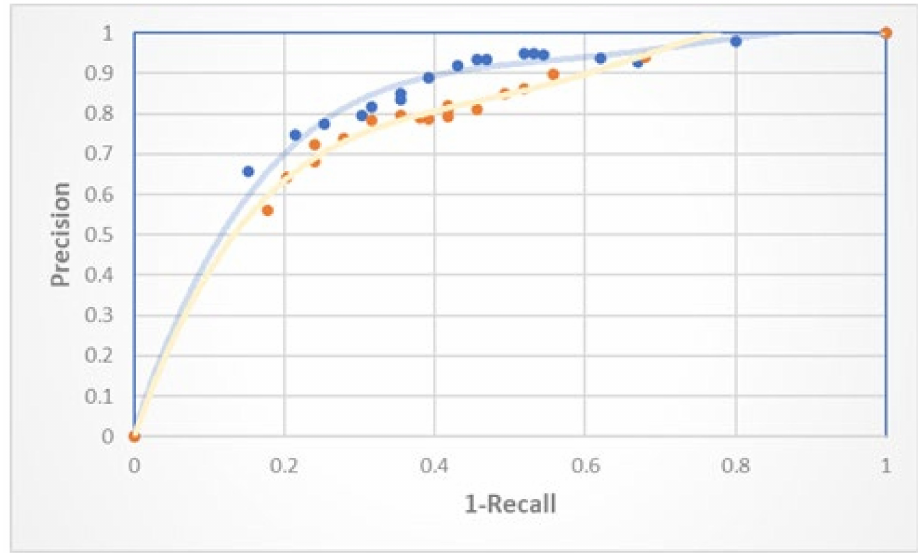
Figure 7. Recall–precision curve. The red curve is obtained without using hard example mining. The blue curve is obtained using hard example mining. The dots are the experimental results, while the curve is the curve-fitting of the dots. Please note that the abscissa is reversed by